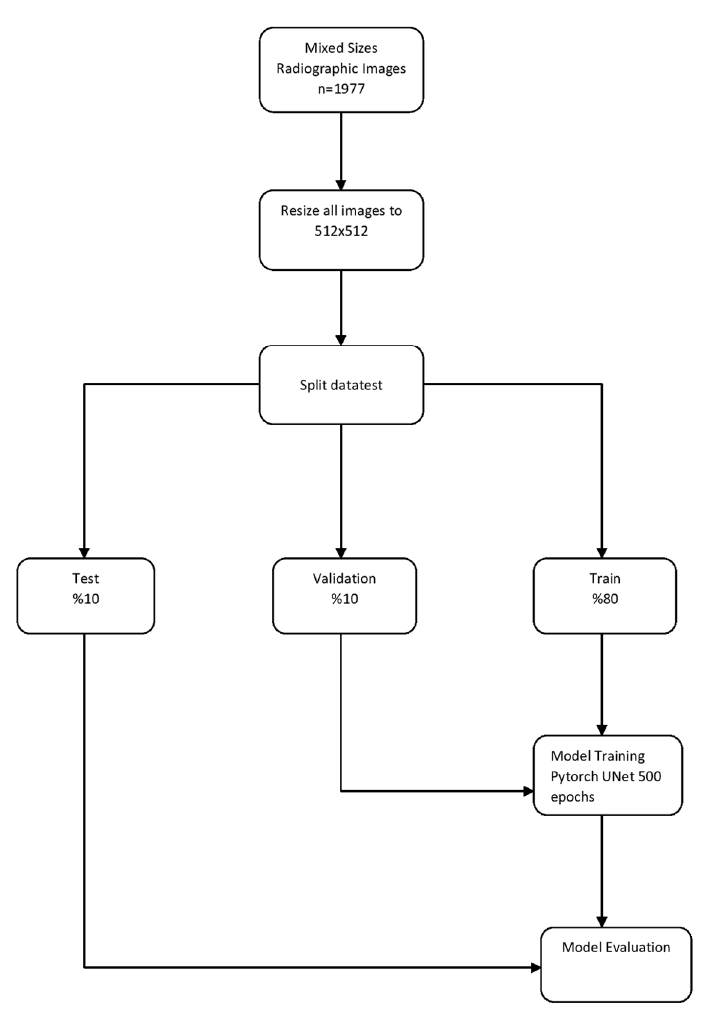
Figure 2. Model pipeline of automatic sella segmentation.